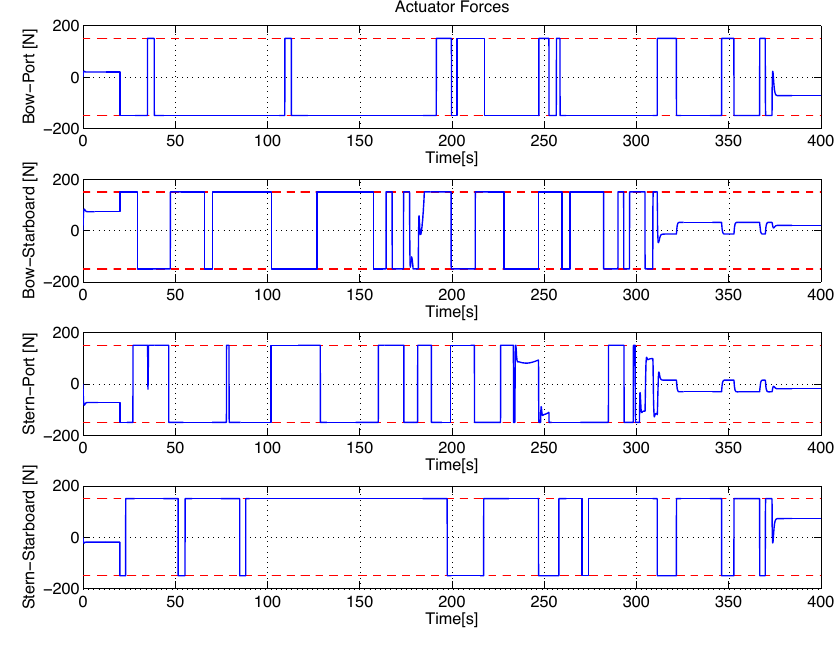
Figure 10: Actuator forces for a vehicle change in position while in current for the case where the anti-windup is not